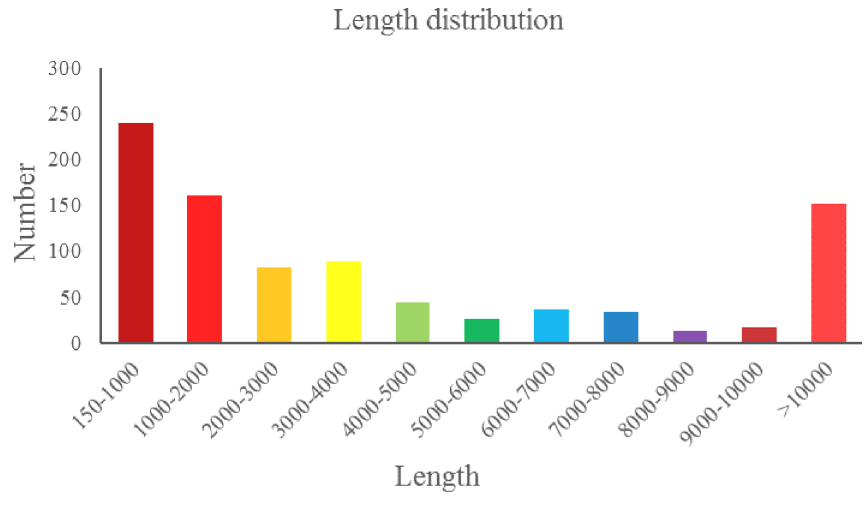
Fig 1. Length distribution of pear circRNAs.